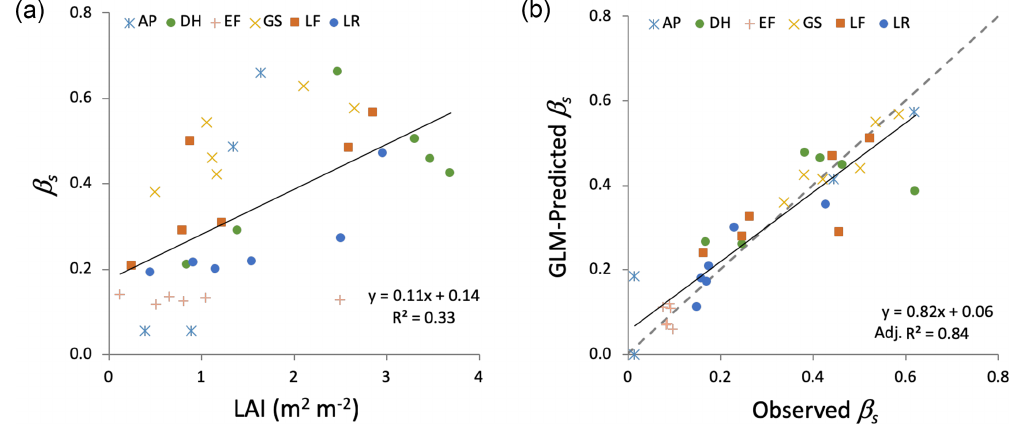
Figure 4. (a) Interception storage capacity ( β s ) versus leaf area index (LAI) for all sites and plots. (b) Modeled versus observed β s using the best GLM, which included % GC vegetation and an interaction term between site and LAI. The dashed line is the 1 : 1 line.